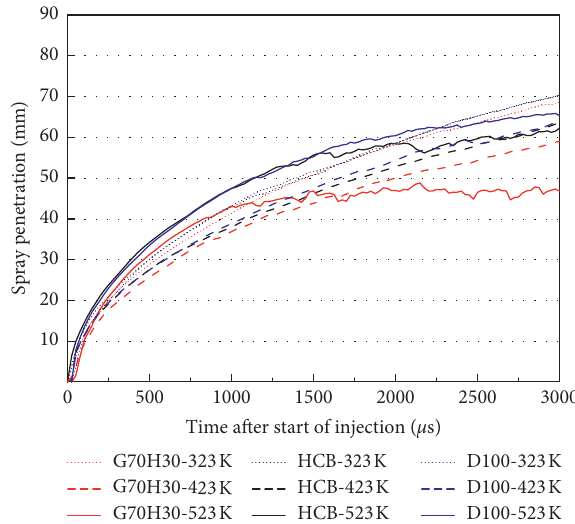
Figure 4: Liquid spray penetration versus time for D100, HCB, and G70H30 fuels under different ambient